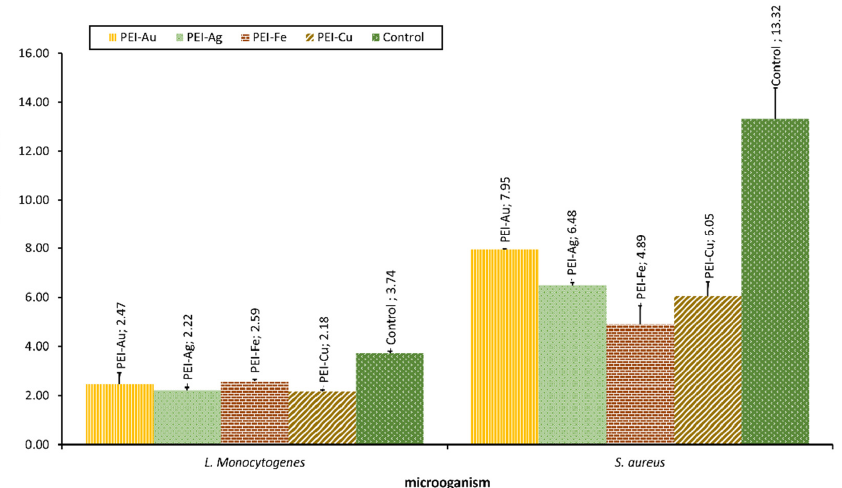
Figure 5. The optical density of bacterial strains L. monocytogenes and S. aureus after 24-h culture in the presence of nanocomposite membrane material based on polyethyleneimine (PEI) with